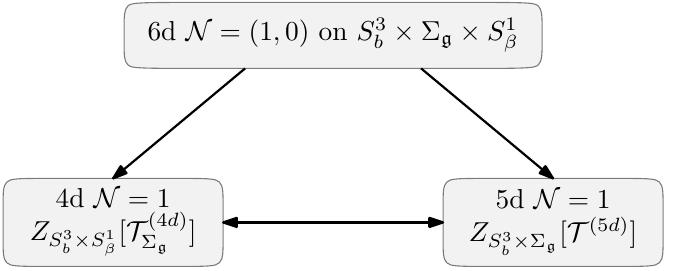
(cid:2) S 1 from the partition b (cid:12)